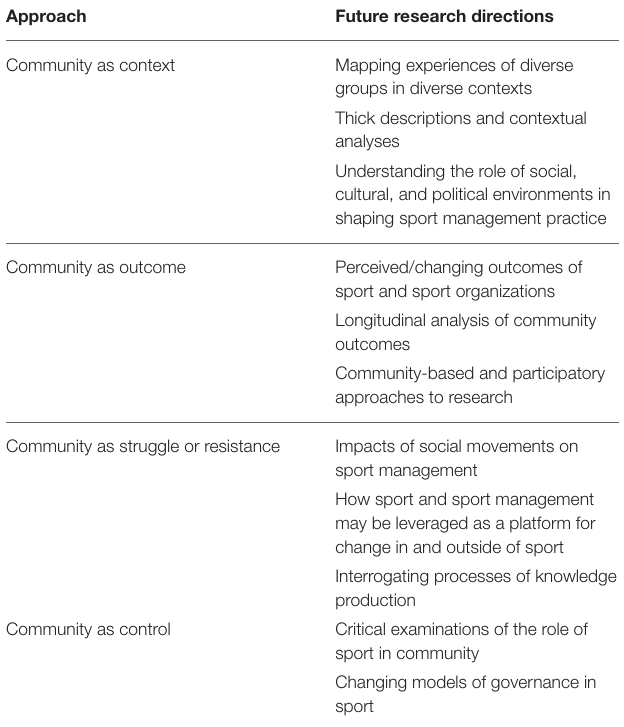
TABLE 2 | Future research directions for community in sport